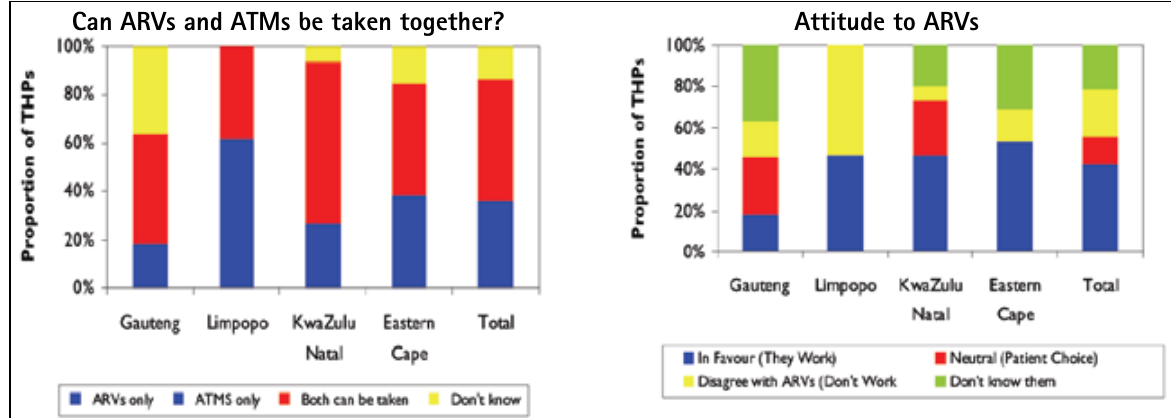
Fig. 4. THPs’ attitudes to ARV